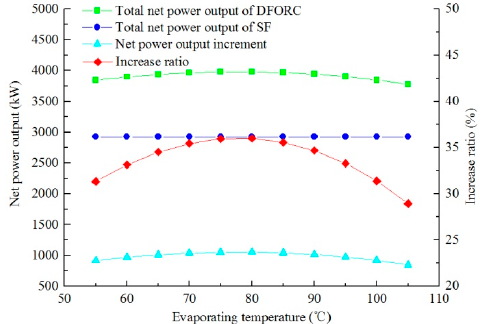
Figure 7. Variations of net power output of DFORC with evaporating temperature (geofluid temperature = 180 °C, steam dryness = 0.2, geofluid flow rate = 150 t/h).